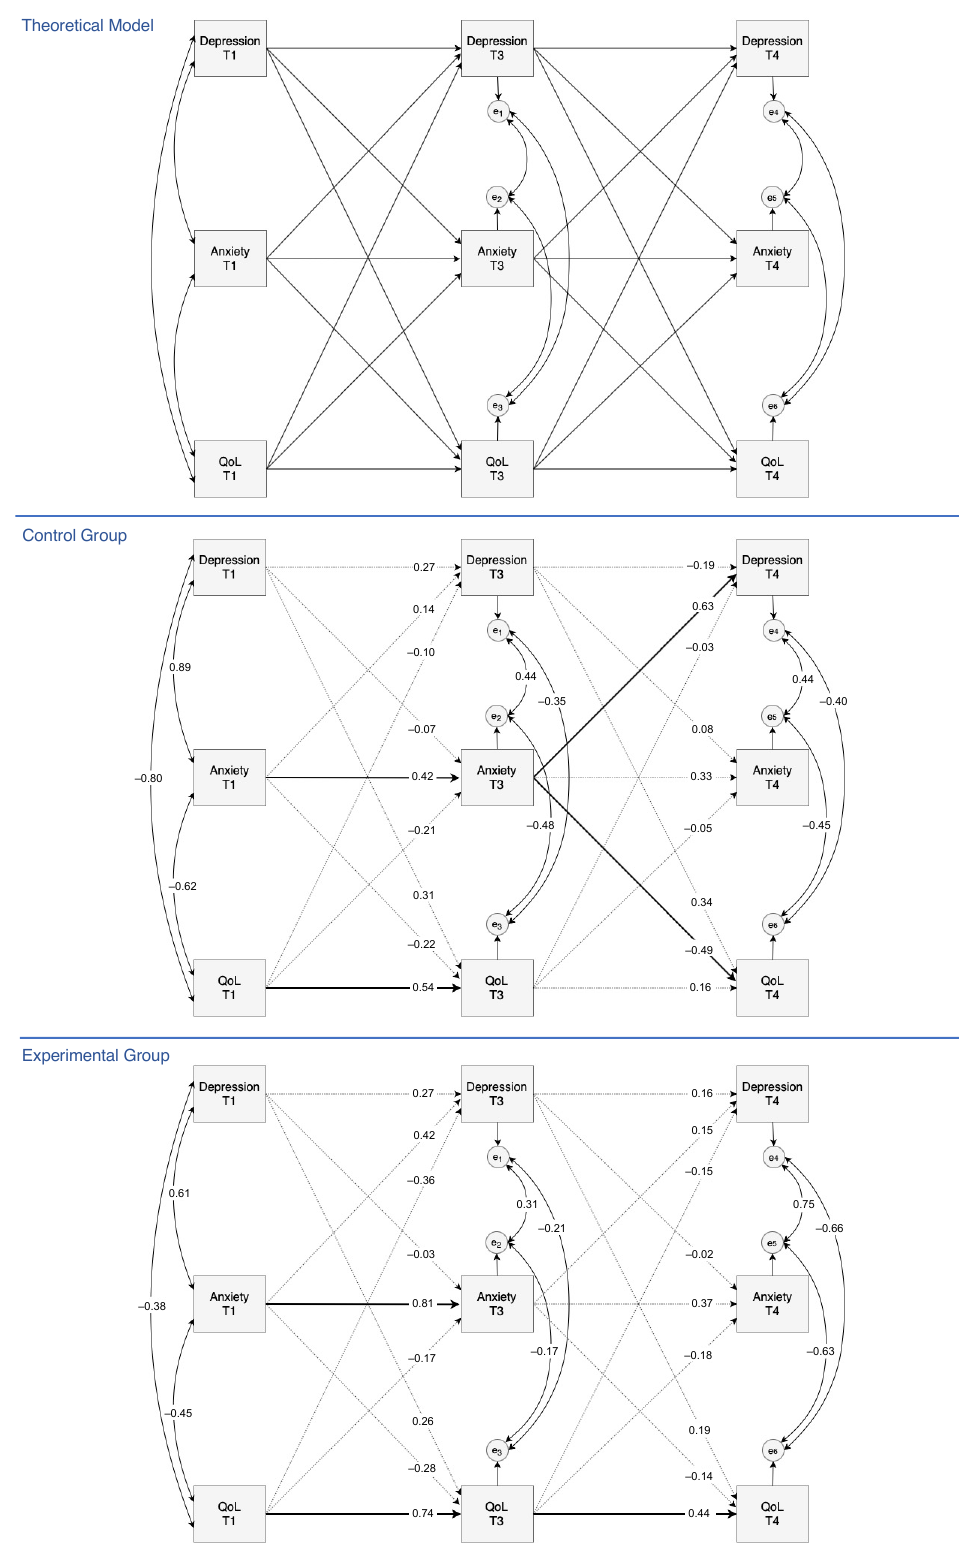
Figure 3. Three-wave structural equation theoretical model with autoregressive and cross-lagged effects for the longitudinal relationship between anxiety, depression, and QoL (up). Below, the model estimation for the control group and for the experimental group. Solid lines represent significant relationships and dotted lines represent no significant